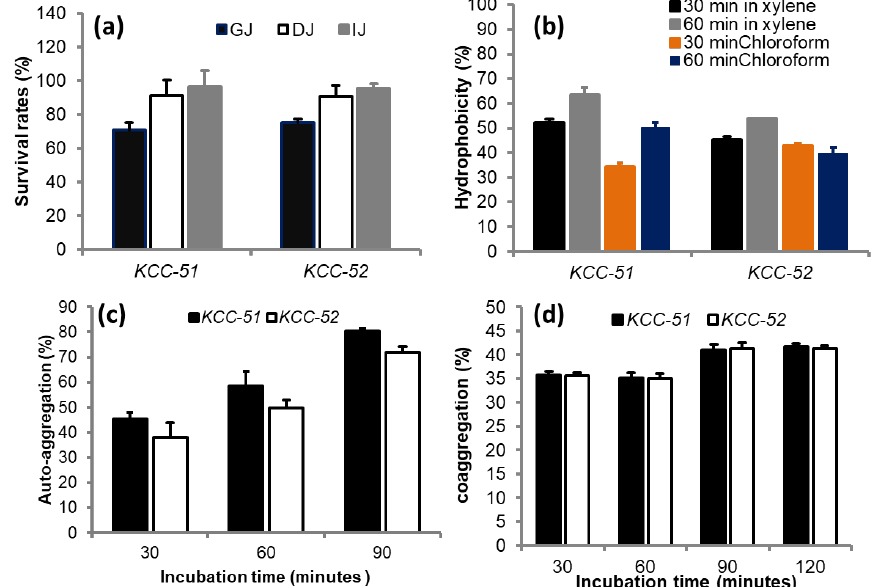
Figure 3. Probiotic features of KCC-51 and KCC-52. ( a ) Survival ability in simulated gastric juice (GJ), duodenal juice (DJ) and intestinal juice (IJ); ( b ) hydrophobicity property of KCC-51 and KCC-52 in xylene and chloroform; ( c ) auto-aggregation of strains; ( d ) co-aggregation of ability of KCC-51 and KCC-52 with E. coli. Data are expressed as the mean ± S. E.M. of three replicates. Analysis was performed with three technical replicates from each sample.